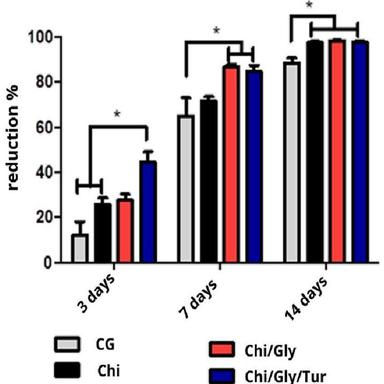
(A) Macroscopic evolution of wounds. (B) Wound repair quantitative evaluation.